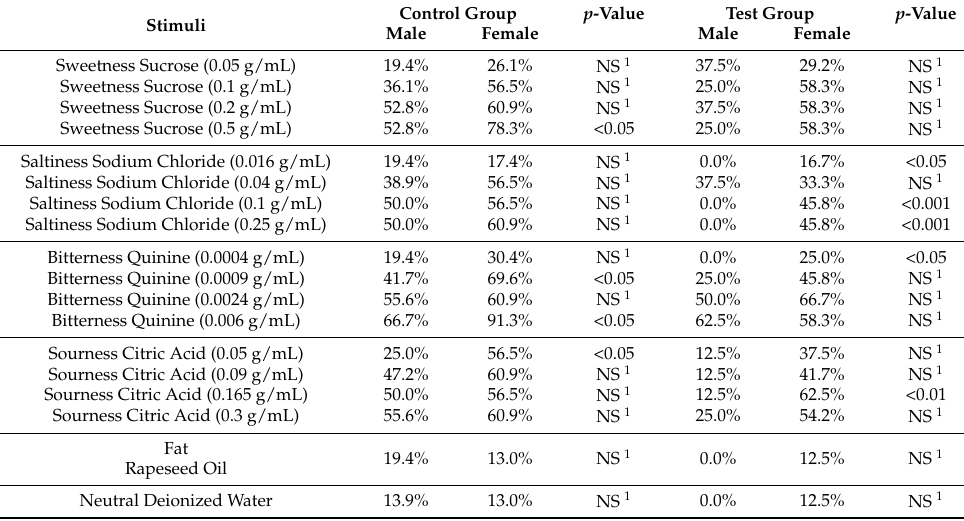
Table 4. Taste stimuli test: percentage of correct answer in the study